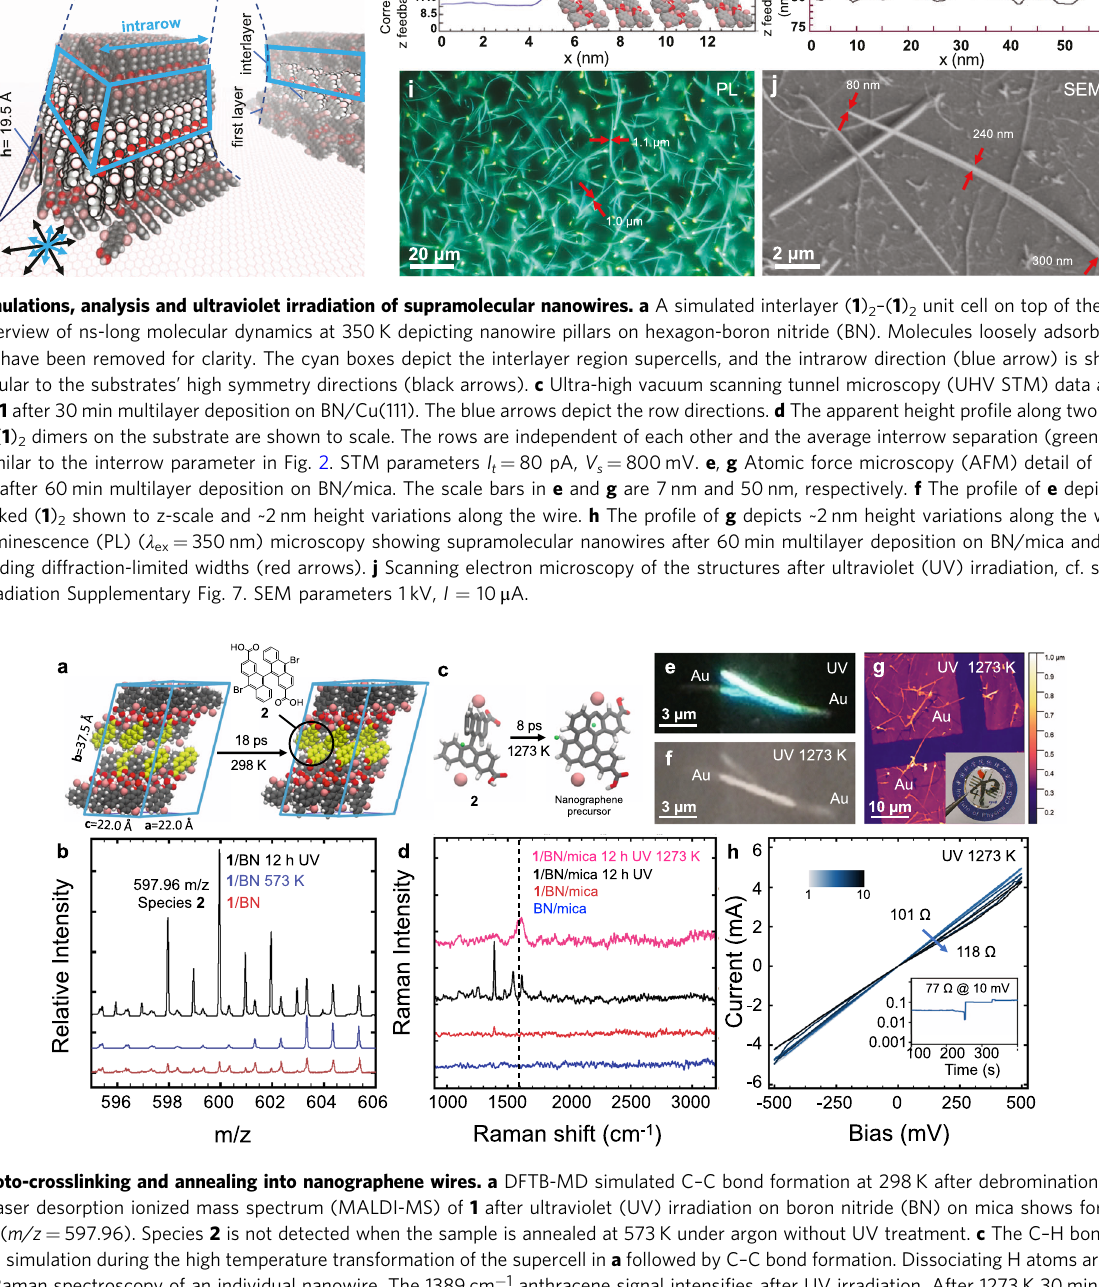
NATURE COMMUNICATIONS| (2022) 13:442